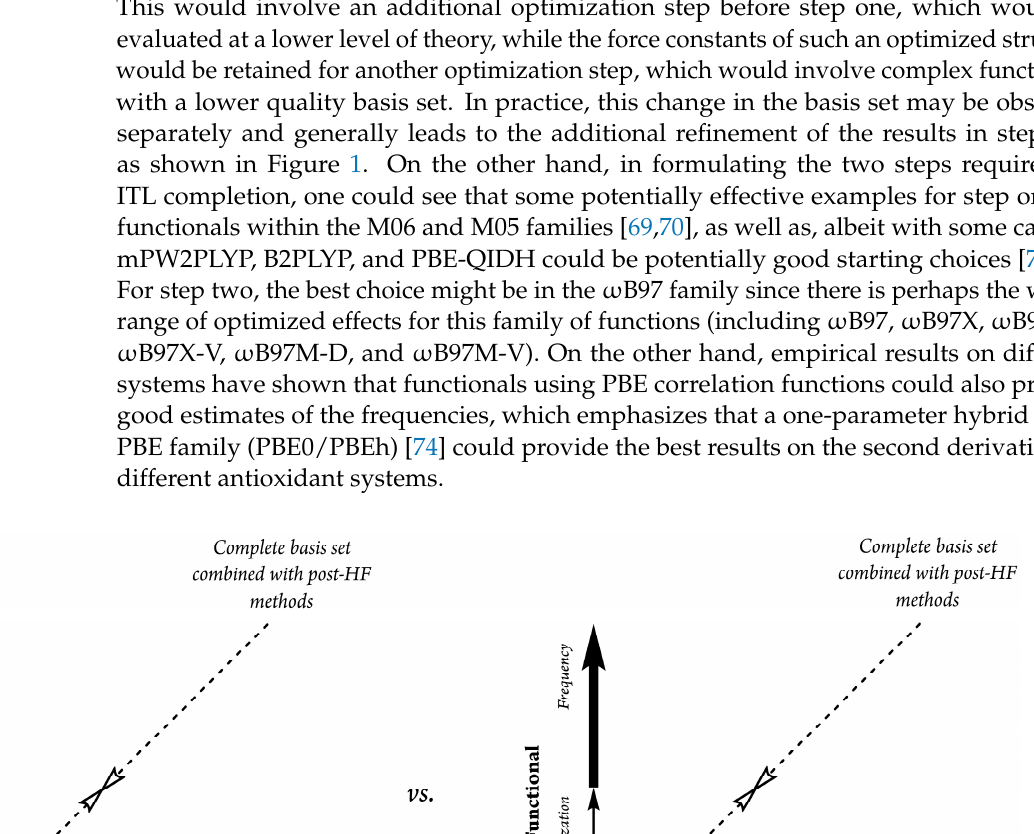
Figure 2. Graphical interpretation of the difference between the standard functional optimization step for frequency computation ( left ) and the ITL methodology approach ( right ). For the optimization process, the selected theory level B3LYP/6-311G(d,p) (the purple and dark yellow dots, respectively, corresponding to the functional/basis set notation) was used, with the subsequent use of M062X/cc-pVQZ (the red and blue dots, respectively) for the frequency calculation to describe the standard optimization path. In contrast, the ITL methodology was described by the inversion in theory used; the same M062X/cc-pVQZ was used for the optimization process, while ω B97X-V/pcseg-1 (the green and orange dots, respectively) was chosen as the level of theory for the frequency calculation in this type of approach. The theories mentioned in this heading are exemplary. When used as a multi-step ITL, step one should include some GGA or meta-GGA functions, such as TPSS or M11L, followed by the second step with a hyper-meta-GGA theory level function (e.g., M052X). The third step should be in the same framework as the standard ITL. Figure 2 graphically summarizes the differences between ITL and the classical approach (also called the proportional approach).